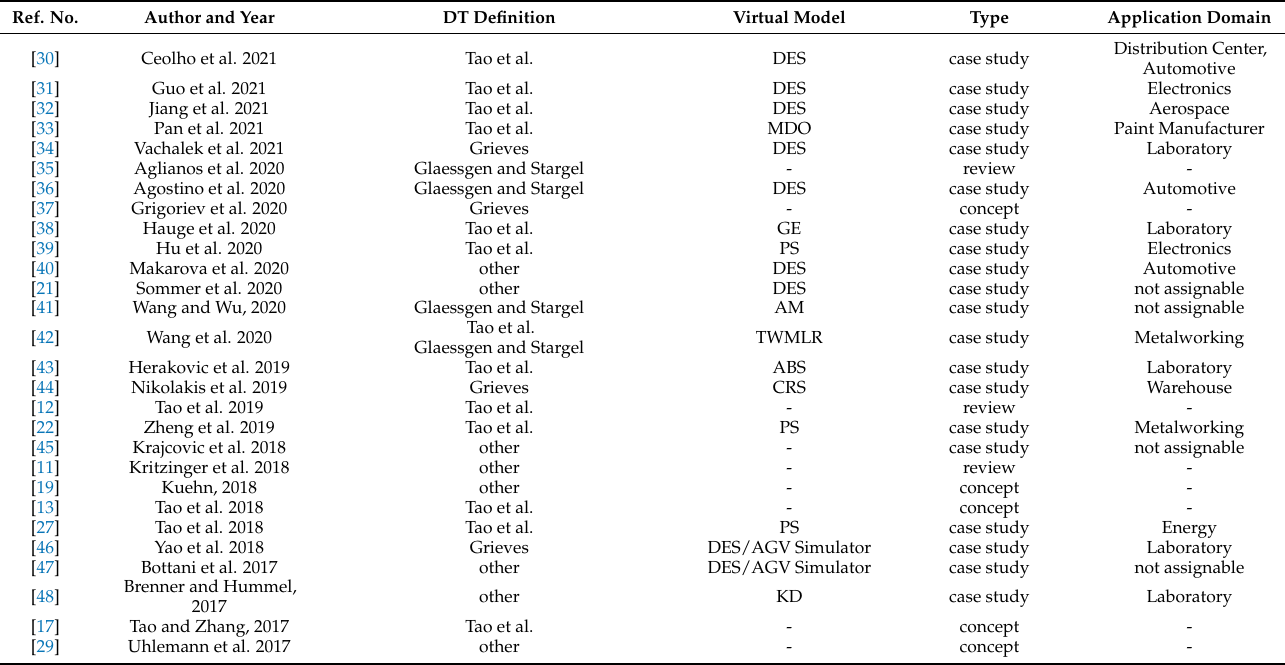
Table 7. Studies included in the review.